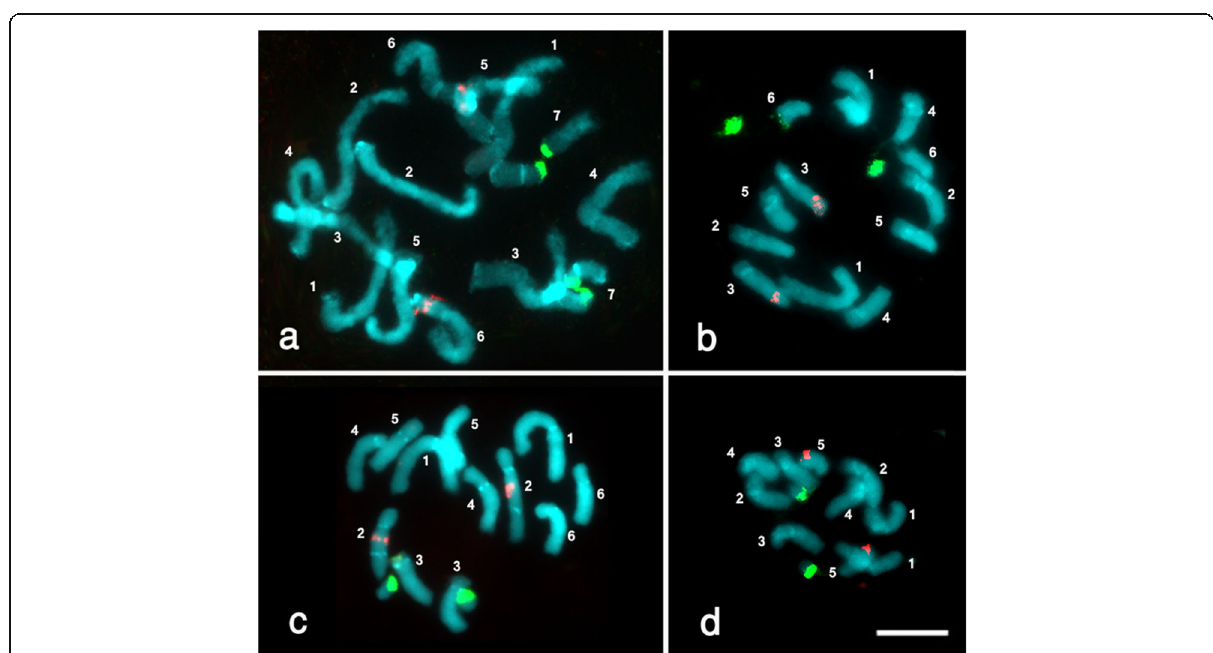
Fig. 1 Mitotic metaphase chromosomes of four Vicia species after FISH with rDNA probes; 18S-25S rDNA probe was detected by FITC (green signals) and 5S rDNA probe by Texas red (red signals). The chromosomes were counterstained with DAPI. a Vicia johannis (2n = 14). b Vicia angustifolia (2n = 12). c Vicia dalmatica 2n = 12. d Vicia cordata (2n = 10). Bar = 5.0 μ